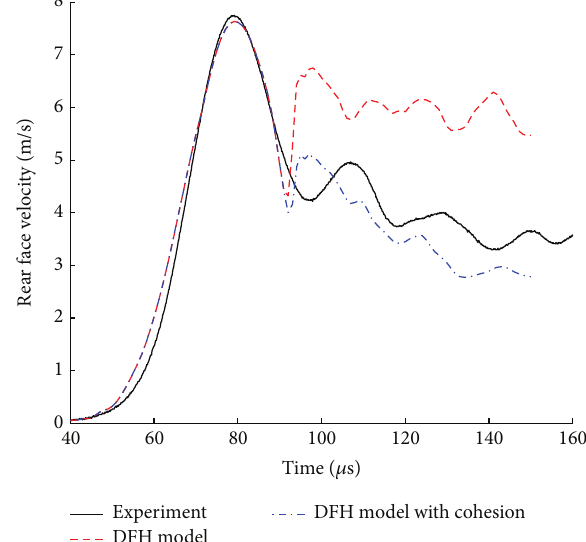
Figure 9: Finite element and experimental results from the spalling test for rear face